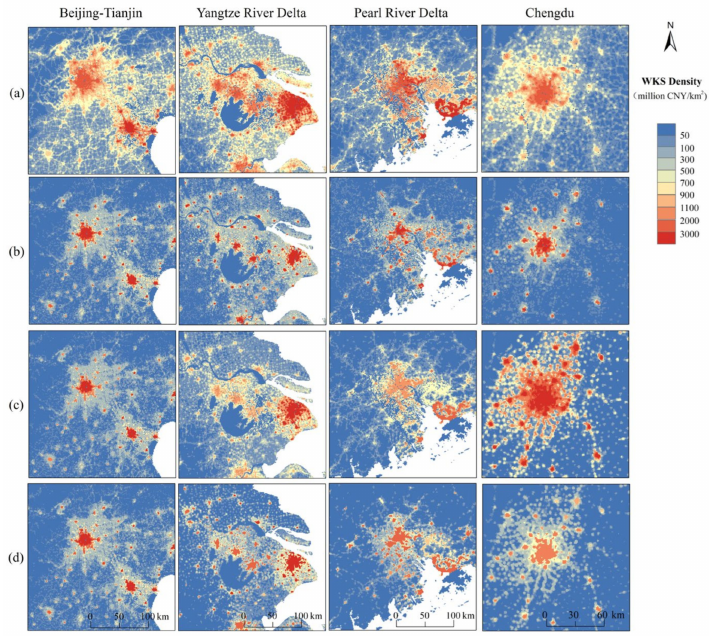
Figure 4. Comparison of the WKS maps by using the ( a ) RF, ( b ) cubist, ( c ) XGBoost, and ( d ) stacking models for four metropolitan agglomerations in